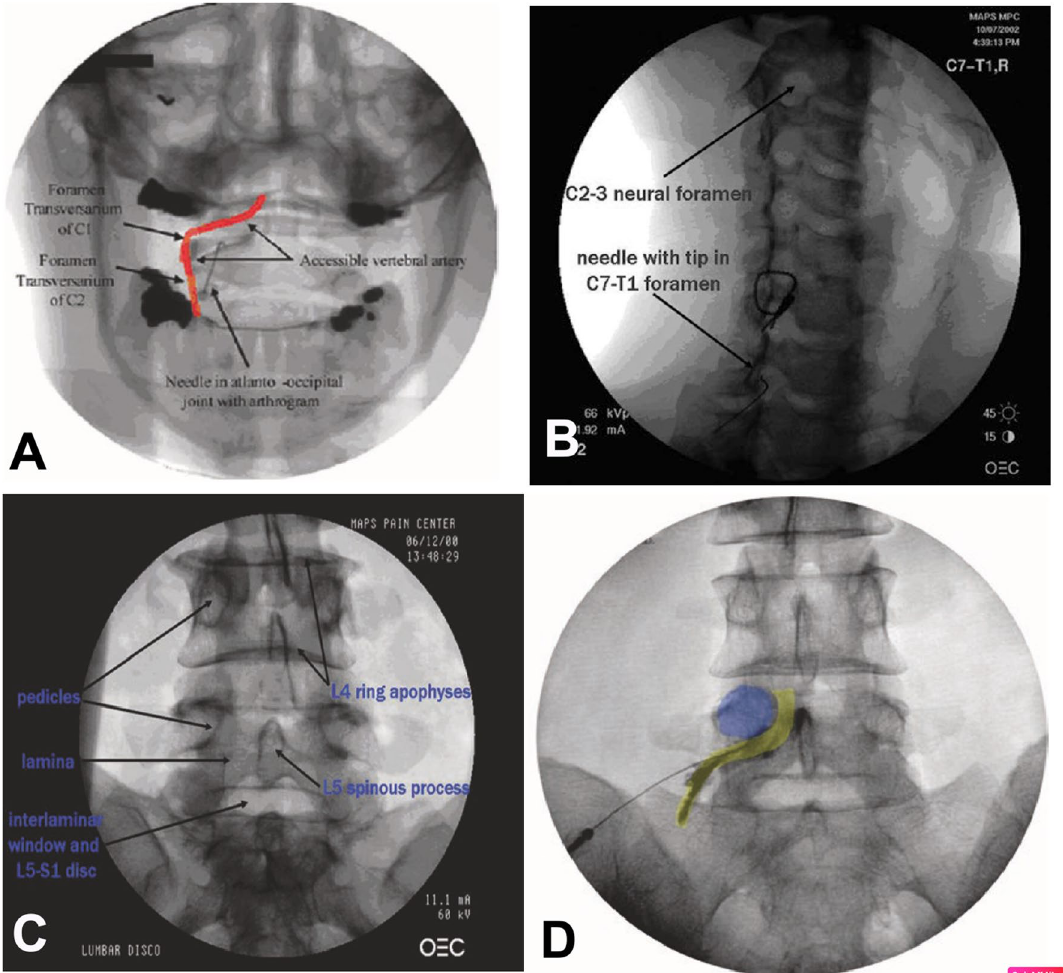
Fig. 1 Fluoroscopic images showing; A the location of vertebral artery passing lateral to the atlantoaxial joint and the dense centralized between both atlantoaxial joints in “open-mouth view”. The needle can be seen inside the atlantoaxial joint. B oblique lateral view of the cervical spine showing the pedicles of vertebrae and C2-3 through C7-T1 neural foramina with the tip of the needle at the posterior aspect of C7-T1 foramen dorsal to C8 nerve root. C Antero-posterior view of lumbar spine with ring apophyses of L5 squared up to obtained a true AP view. The spinous process is centralized between both pedicles which appear as two rounded hyper dense areas at superior aspect of L5 vertebra bilaterally. D The relation of the exiting nerve root to the corresponding pedicle. The tip of the needle can be seen inferior to the pedicle for transforaminal